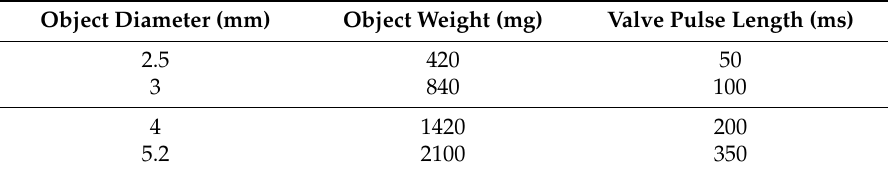
Table 2. Solenoid valve pulse length regulation for different object sizes and weights.